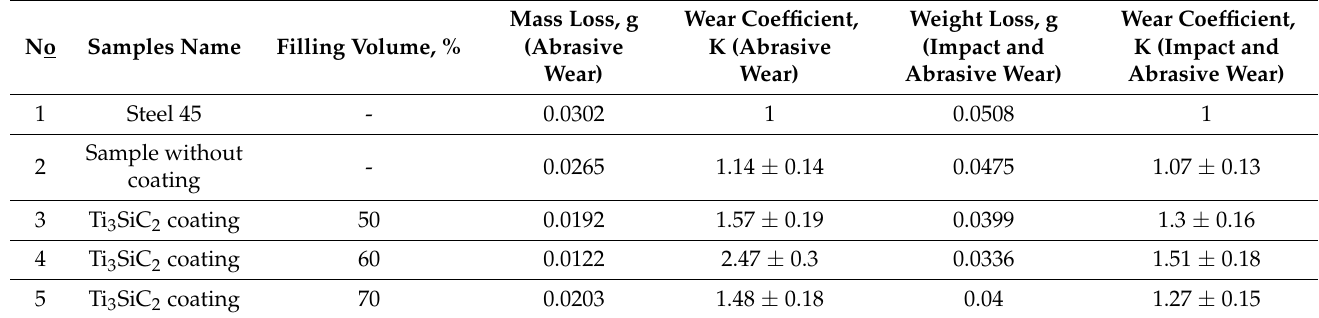
Table 2. Abrasive and impact-abrasive wear test